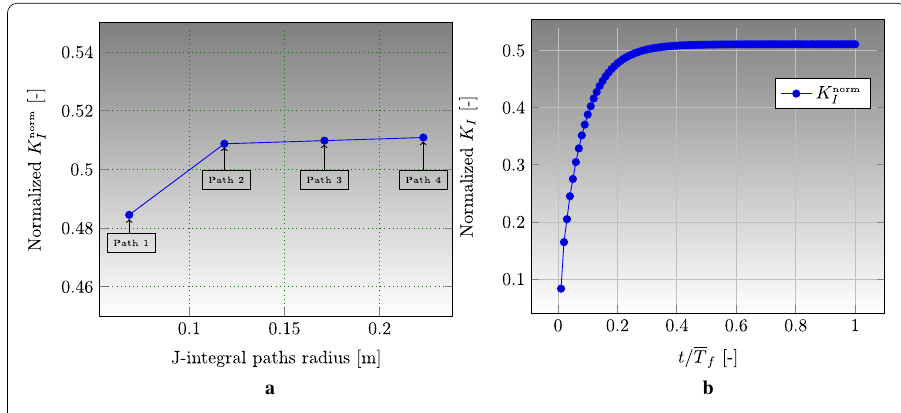
Fig. 19 Edge cracked strip under transient thermal load: a normalized K I versus J-integral paths, at final time T f , b normalized K I over